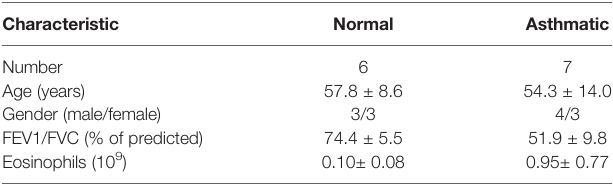
TABLE 1 | Characteristics and physiologies of human